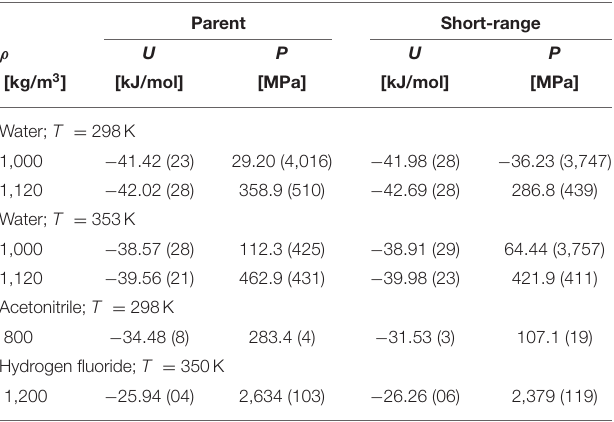
TABLE 1 | Comparison of the internal energy and pressure of the parent and their associated short-range models. Parent Short-range